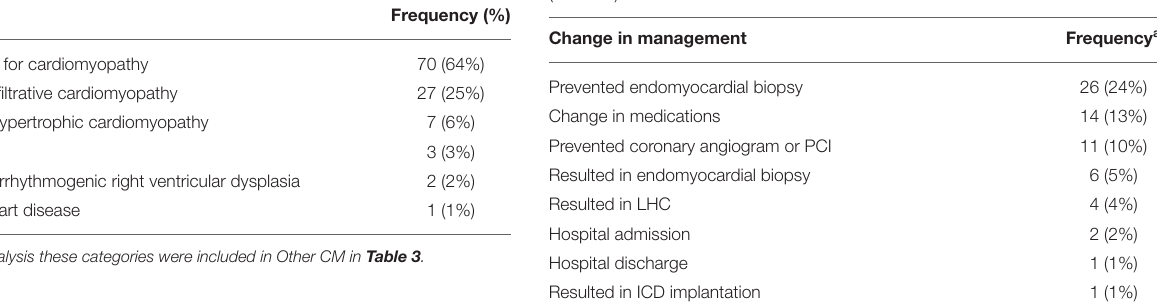
TABLE 4 | Summary of change in management followed by CMR results ( n =